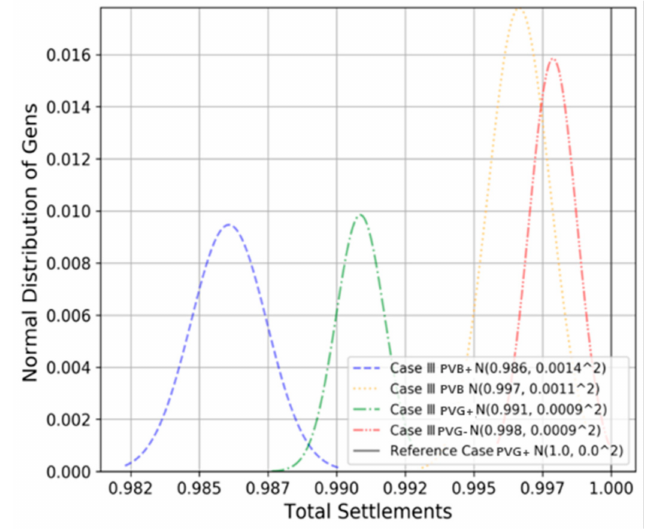
Figure 8. Distribution of PVs revenue in each group under Case III.